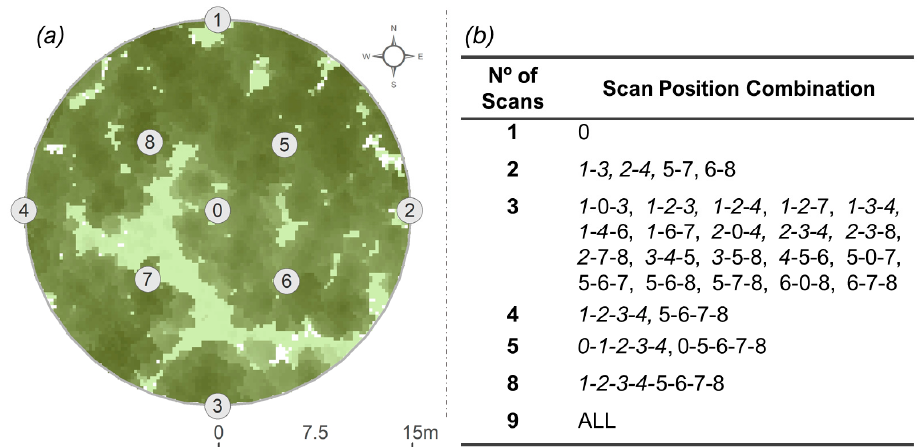
Figure 3. ( a ) Scanner position setting from a zenithal view of a plot, where dark green represents the tree cover and light green represents the lower stratum vegetation cover (shrubs and herbaceous) visible between the canopy gaps. ( b ) Combination of TLS scanner positions involved in the analysis, representing in italics the positions located at 15 m.